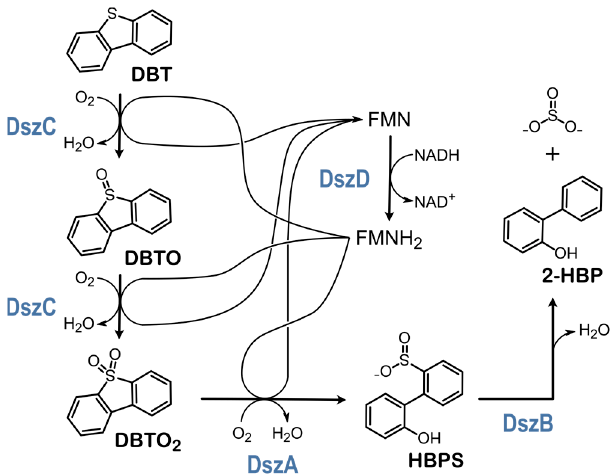
Figure 1. The 4S pathway starts with DszC performing the double oxidation of the dibenzothiophene (DBT) to DBT-sulfoxide (DBTO) and DBT-sulfone (DBTO 2 ), respectively, followed by the first carbon-sulfur bond cleavage performed by DszA; and finally, the formation of 2-hydroxybiphenyl (2-HBP) and sul fi te SO 32 − by the action of DszB.